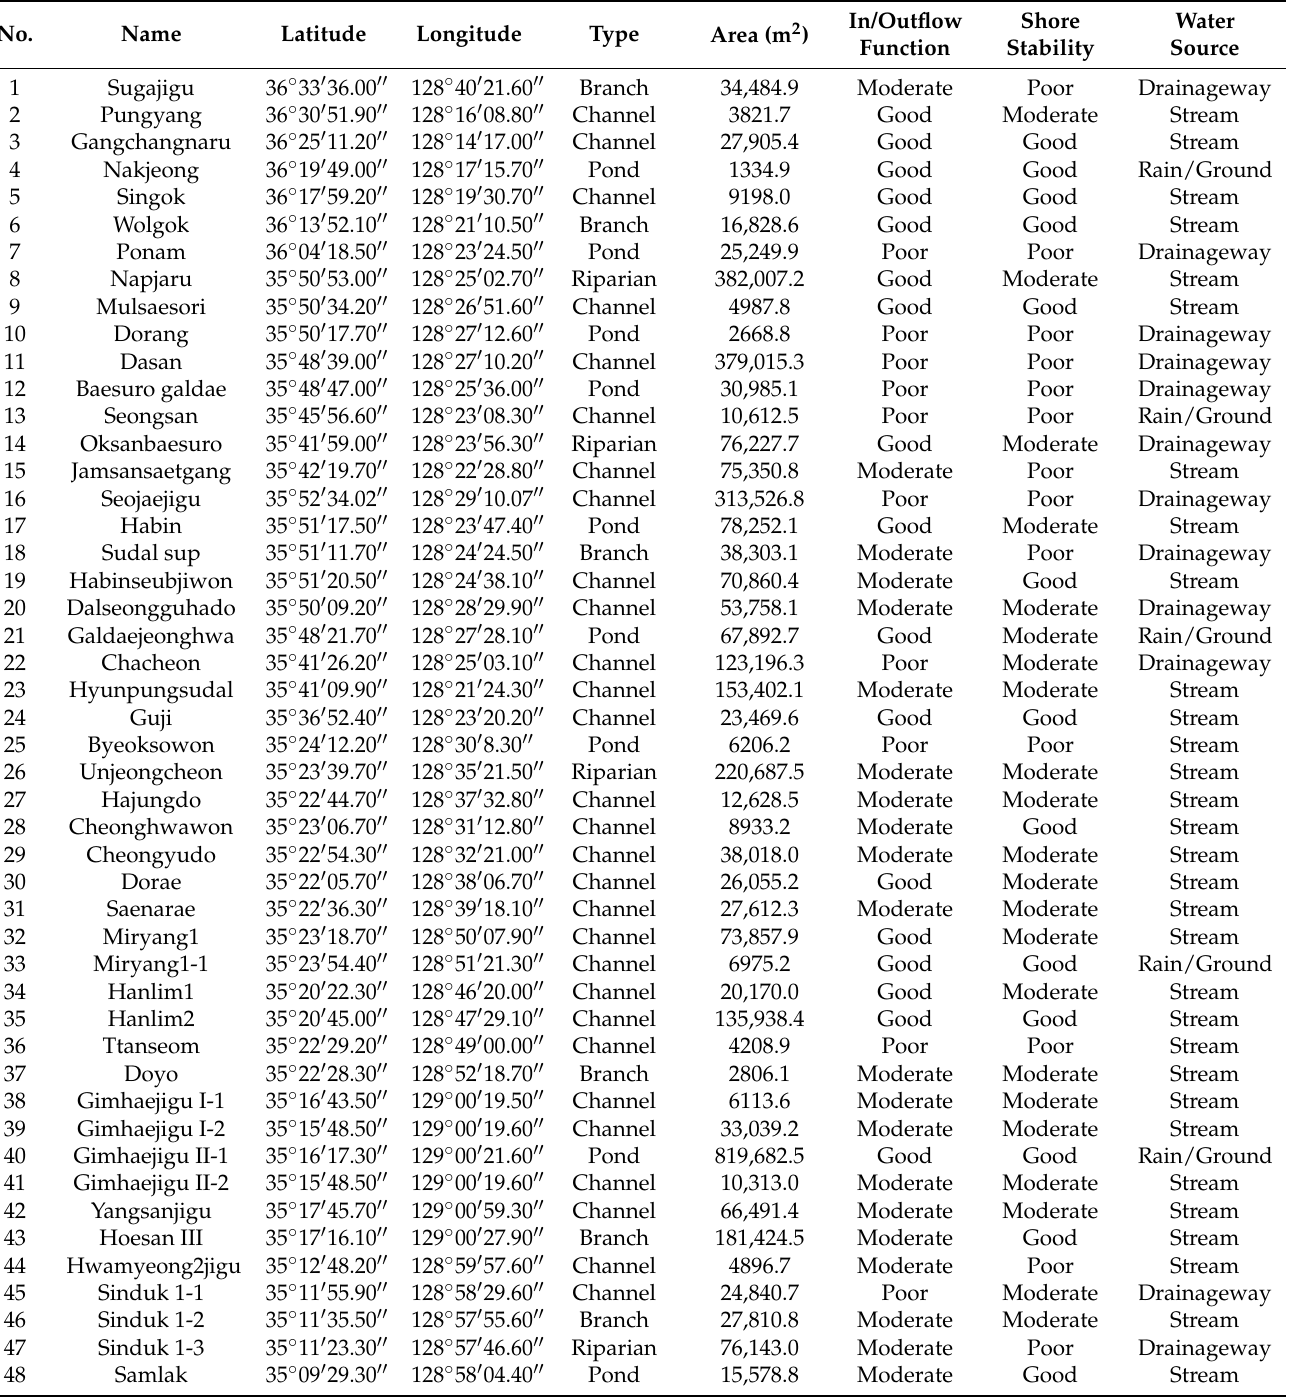
Table 1. Hydrological factors of 48 artificially created riverine